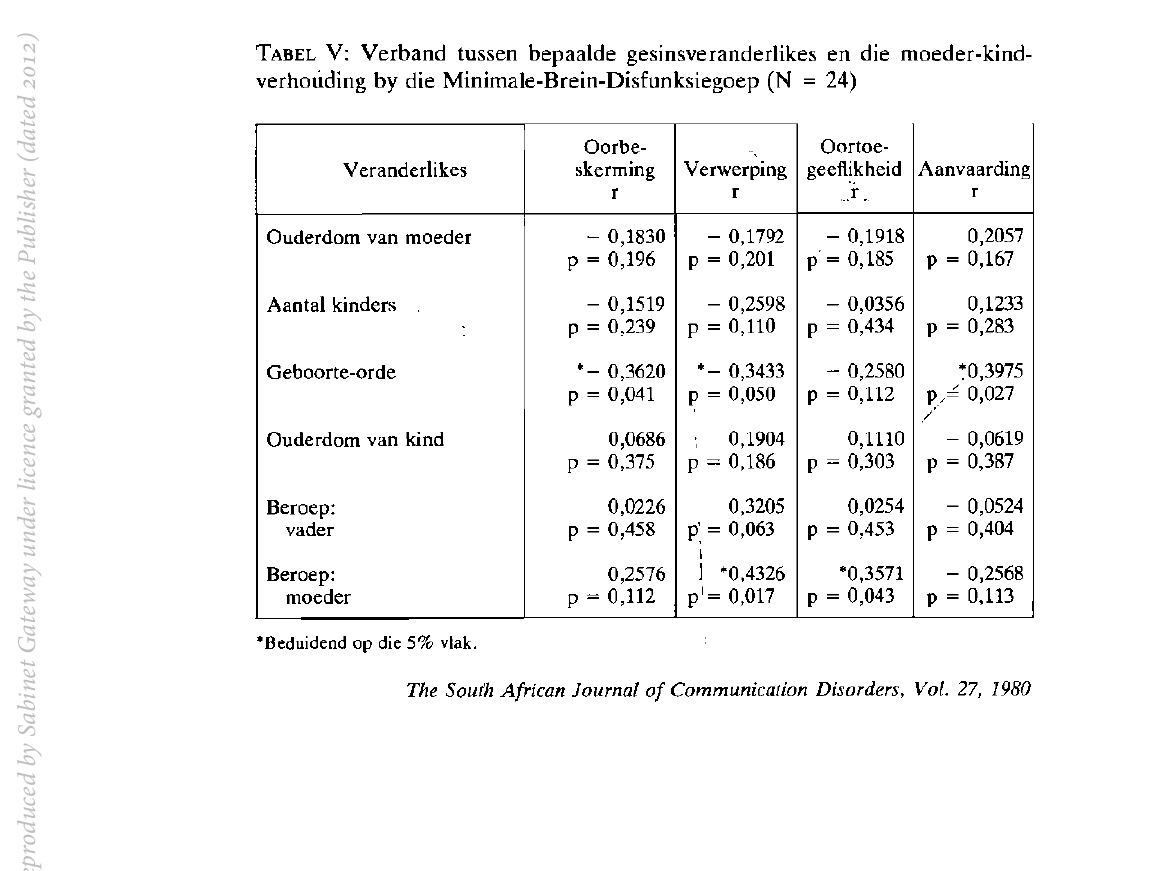
TABEL V: Verband tussen bepaalde gesinsveranderlikes en die